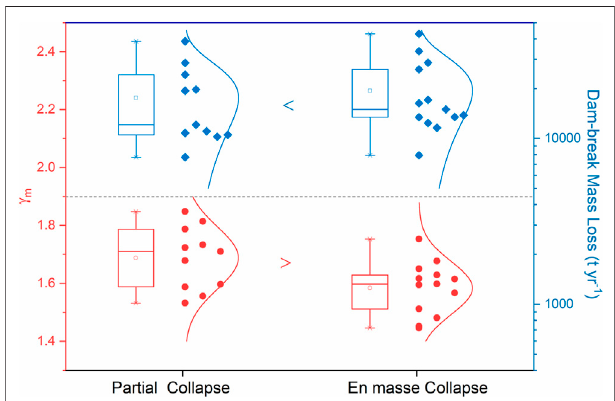
FIGURE8| Magnitudeofsolidmaterialseroded fromdamstructureand speci fi c gravity for debris fl ows developed in partial and en masse dam failure